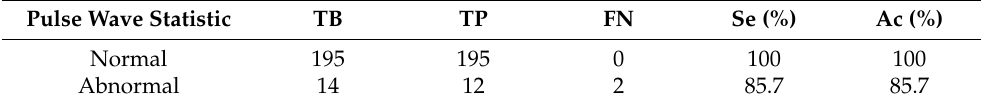
Table 3. Results of analyzing the pulse wave signals of PVC patients.